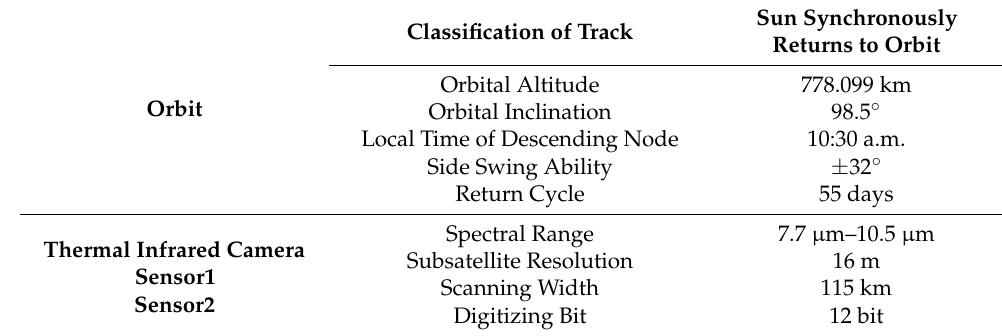
Classification of Track